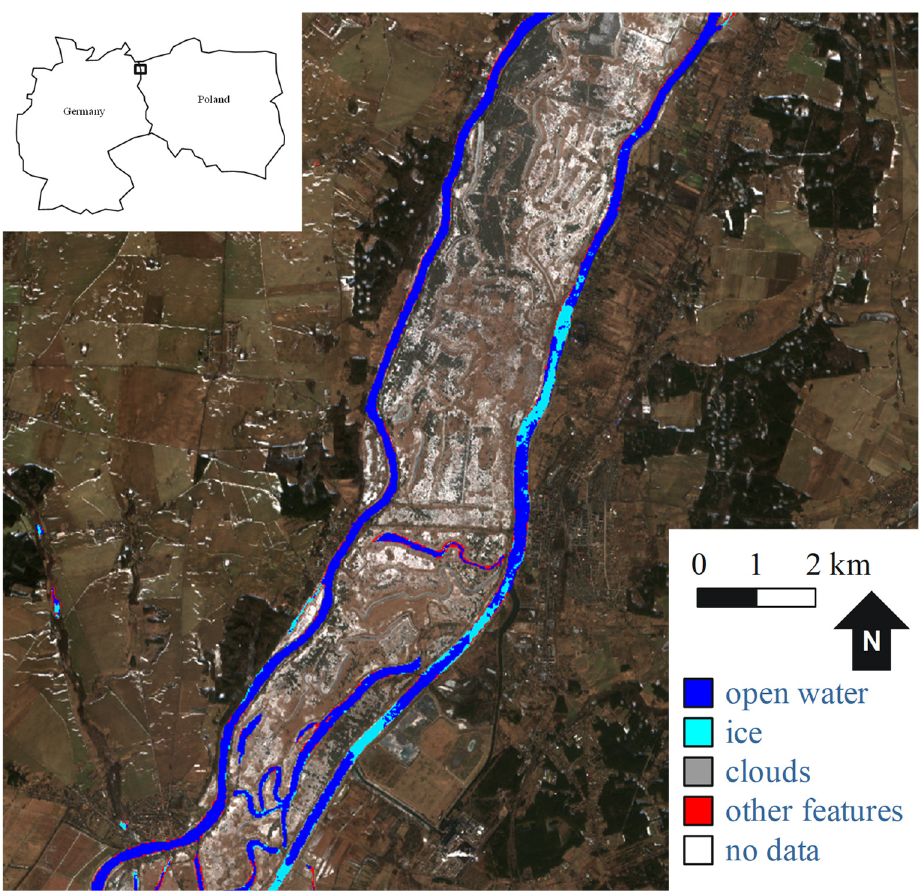
Figure 18. The combined product from Sentinel-1 and Sentinel-2 based classifications. Images credit: https://land.copernicus.eu/pan-european/biophysical-parameters/high-resolution-snow-and-ice-monitoring; images acquired on 16 February 2017.